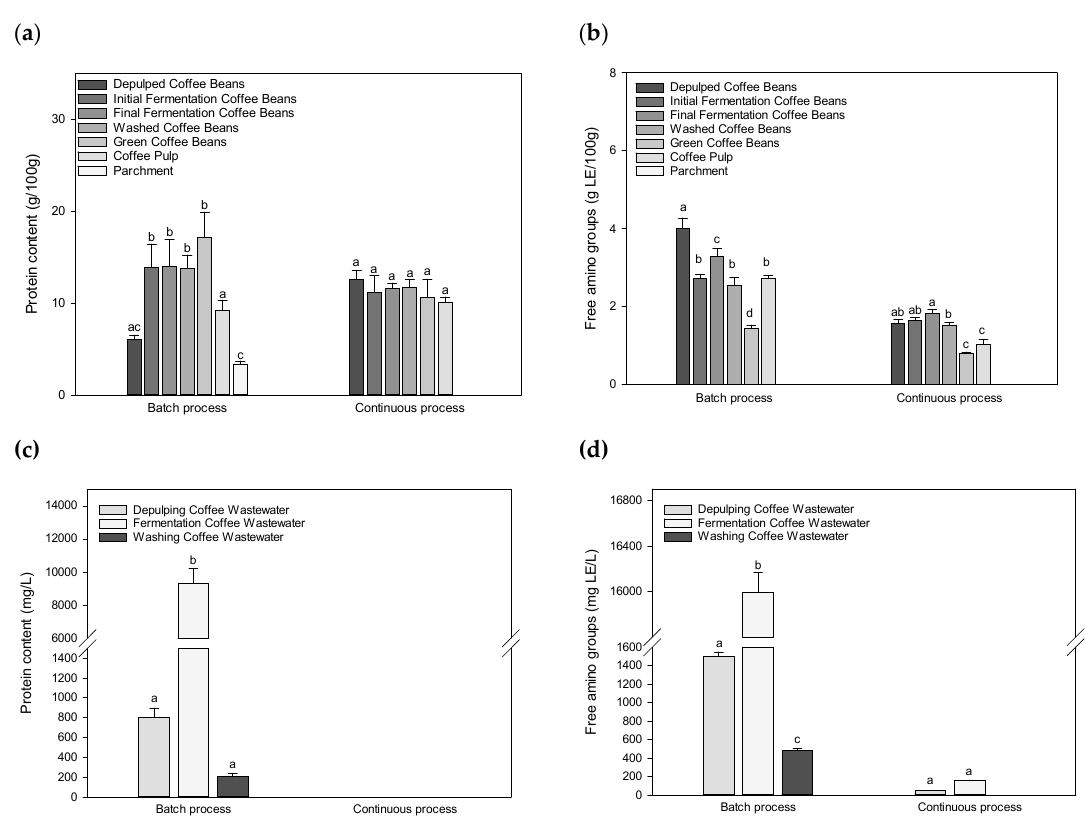
Figure 5. Amounts of protein content ( a , c ) and free amino groups ( b , d ) of coffee beans, by-products and wastewater samples during the wet batch and continuous processing. Data are expressed as means ± standard deviation. n = 3. Different letters indicate significantly different values for each group (different superscript letters indicate a significant different, p < 0.05, ANOVA, Tukey´s test).